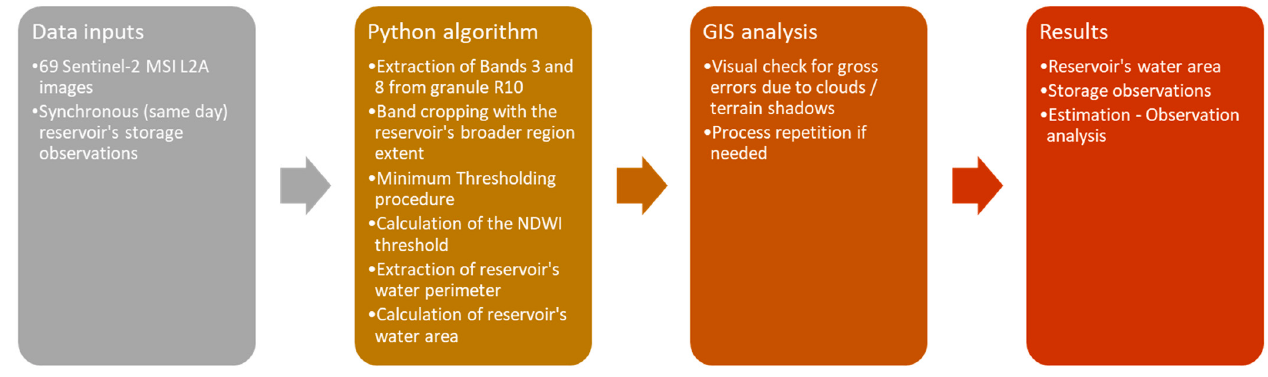
Figure 2. Flowchart of the extraction of water area from Sentinel-2 images and pairing with same-day observations.